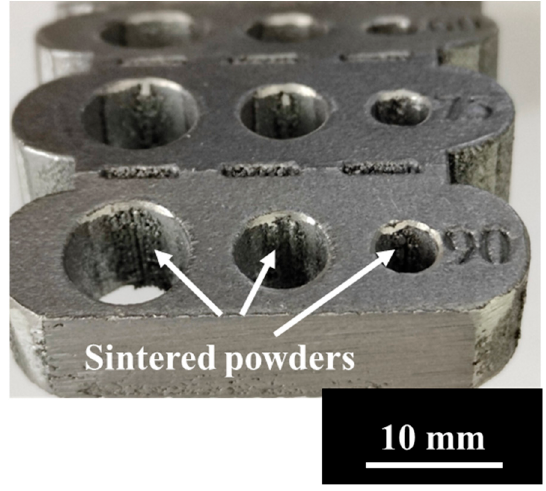
Figure 9. Detail of the surface quality of the produced holes, showing the more prominent sintered powders in the upper region of the holes for the vertically printed element (for the adjacent overhanging elements, this effect decreased gradually).